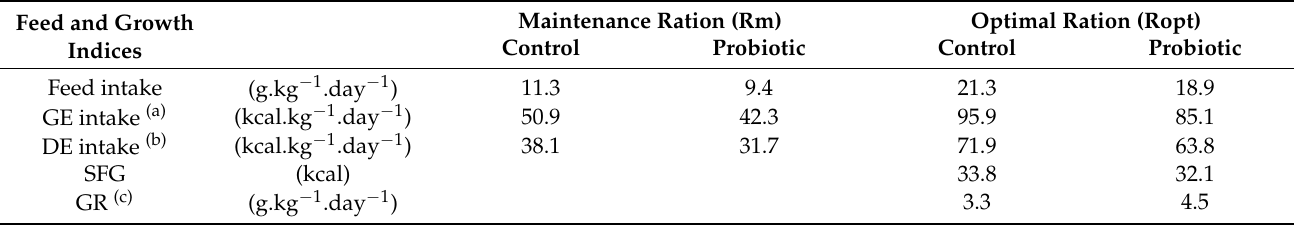
Table 6. Feed, gross energy and digestible energy intake per diet group at the calculated maintenance and optimal feed ration size. Estimate of the “scope for growth” and predicted growth-rate of shrimps at optimal ration